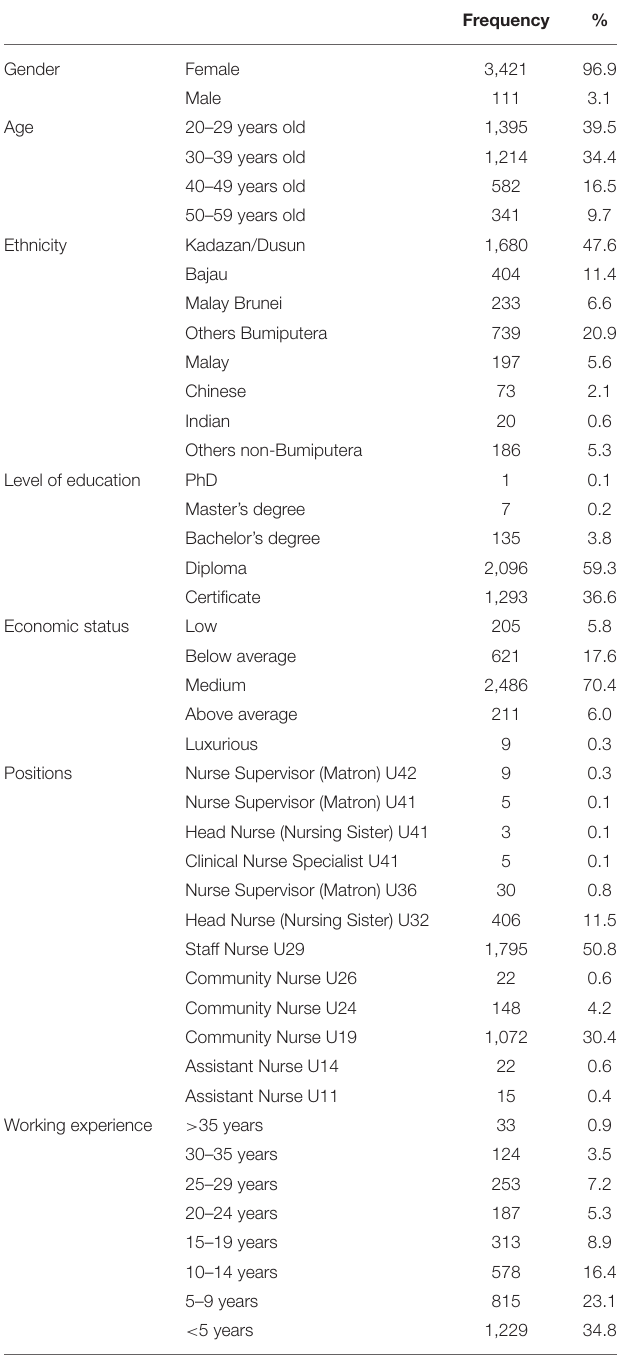
TABLE 4 | Demographic profile of